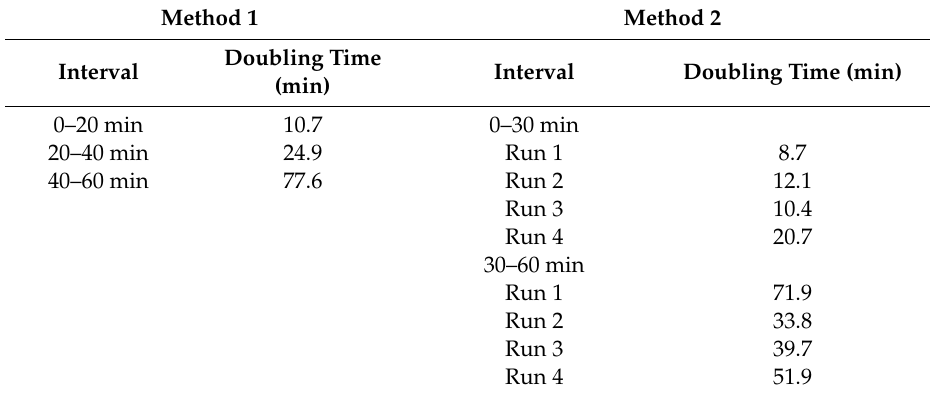
Table 2. Estimates of the signal doubling time of PI (red) fluorescence emission in four assays of Product “A”.